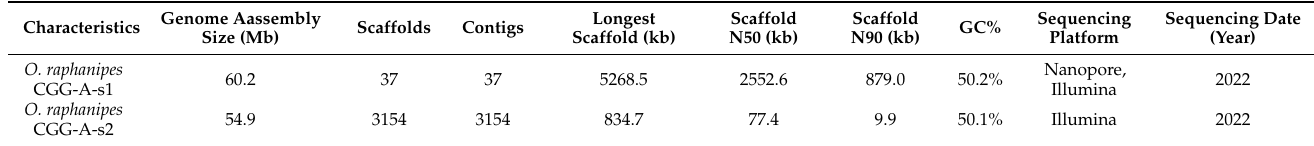
Table 1. Genome assembly features of monokaryotic O. raphanipes CGG-A-s1 and CGG-A-s2.